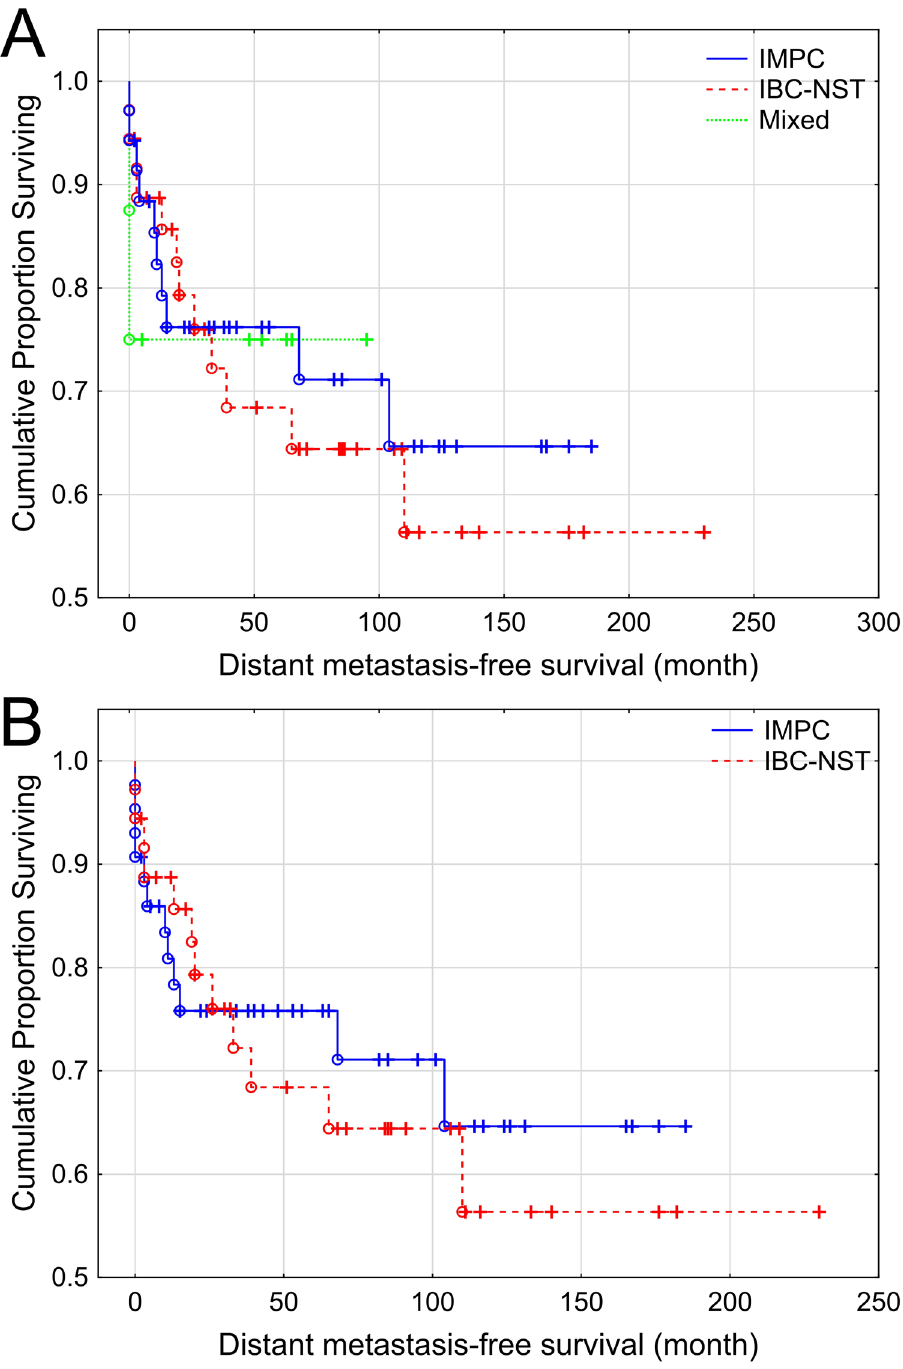
Figure 3. Correlation of histological tumor type with distant metastasis free survival. Based on distant metastasis-free survival, there was no significant difference between IMPC, IBC-NST and mixed IMPC/IBC- NST groups (p = 0.924) ( A ), as well as when comparing only pure IMPC and IBC-NST cases (p = 0.717) ( B